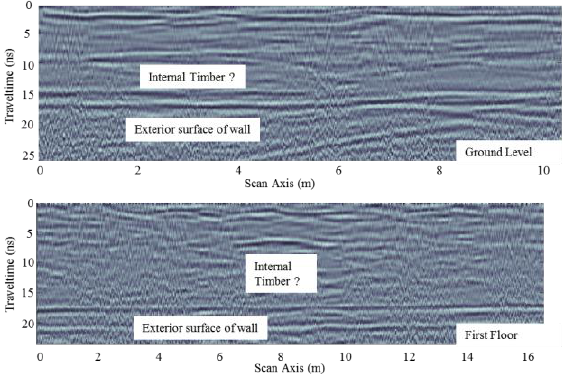
Figure15. Internal elements with vertical continuity in each level in the ground floor (top) and first floor (bottom)